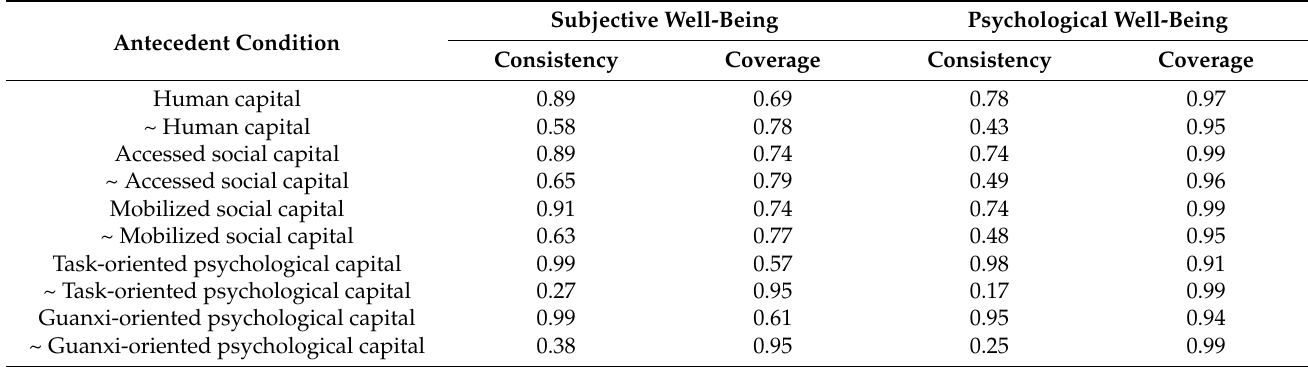
Table 1. Necessity analysis of antecedent conditions for